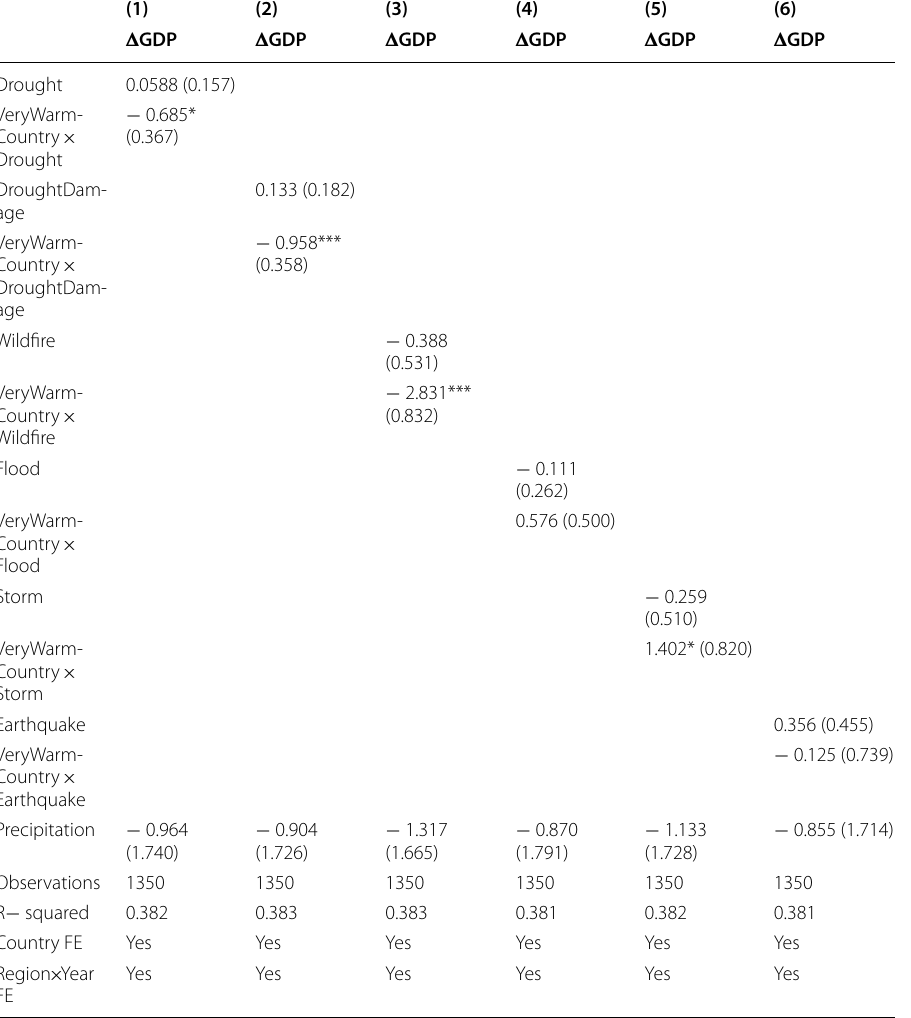
This table shows robustness checks for the potential underlying channels of the temperature–sovereign risk connection. (cid:31) GDP is quarterly GDP growth, aggregated at the yearly level. Drought, DroughtDamage (droughts with a damage report) Wildfire, Flood, Storm and Earthquake are monthly dummies indicating the corresponding natural disaster, which are also aggregated on the yearly level. VeryWarmCountry is a dummy for the countries in the warmest country group, see Table 5. Standard errors (in parentheses) are clustered at the country level and control for heteroscedasticity and serial correlation, ***, ** and * indicate statistical significance at the 1%, 5% and 10% level, respectively. See Table 18 for variable definitions and